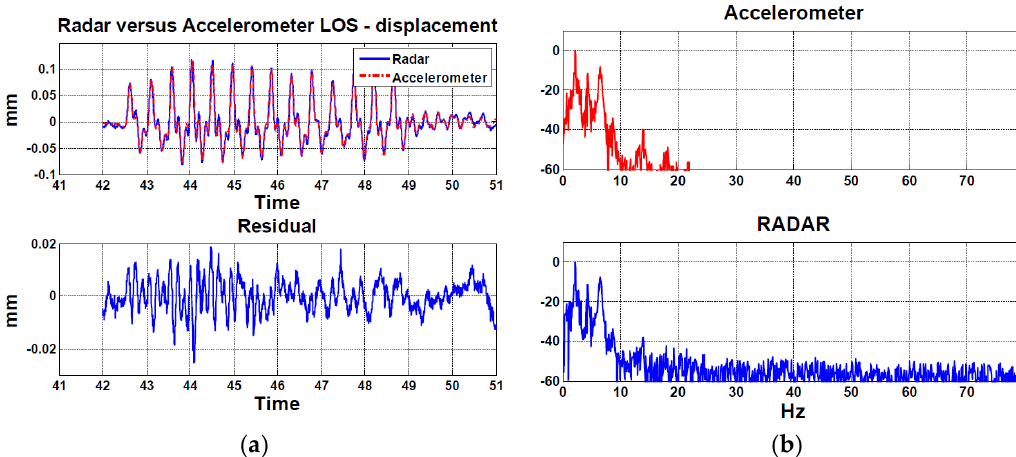
Figure 2. Comparison of the displacements measured by Radar and accelerometers ( a , top ) and residual error ( a , bottom ). ( b ) Power spectra of the two measures.